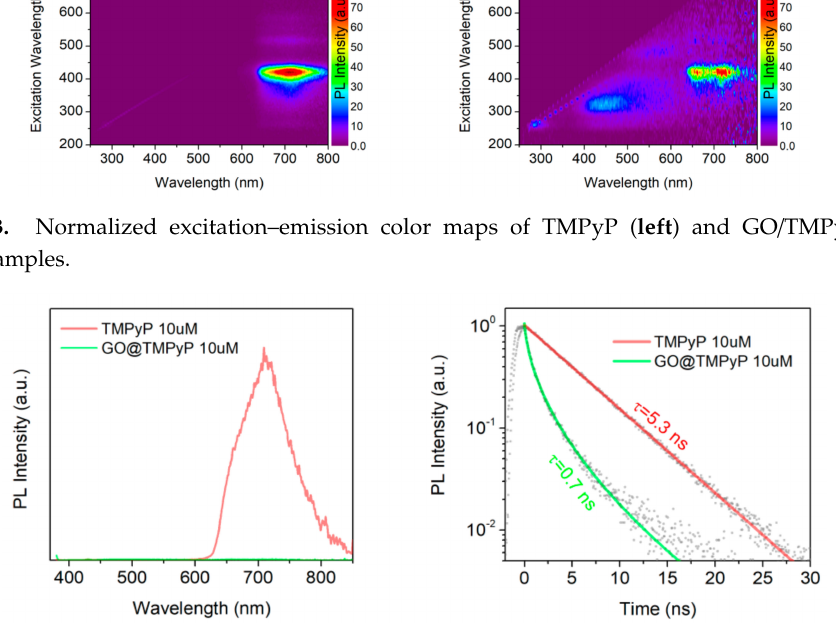
Figure 4. PL emission of TMPyP and GO / TMPyP under the excitation of 375 nm ( left ) and PL decays for TMPyP and GO / TMPyP ( right ). Experimental data are represented by symbols, whereas lines are single or multiexponential fits. Correspondent extracted PL lifetimes are